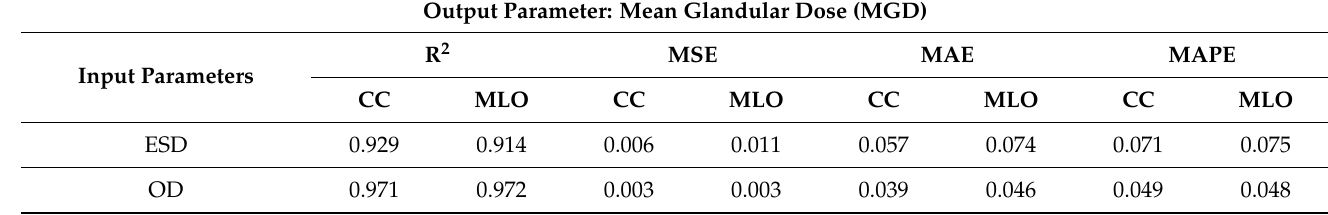
Table 5. Evaluation of regression analysis between entrance skin dose (ESD) and organ dose (OD) as input parameters and mean glandular dose (MGD) for each